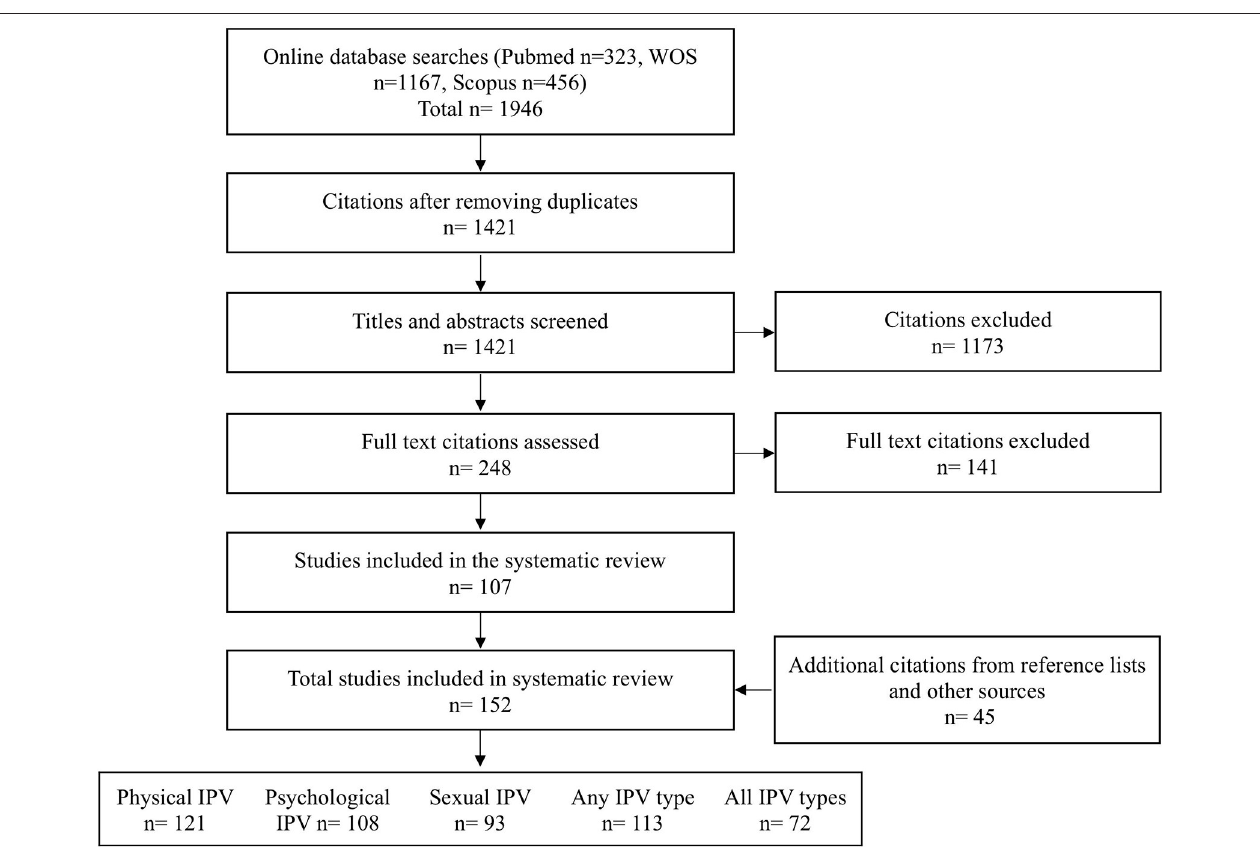
FIGURE 1 | Flowchart systematic review of intimate partner violence during pregnancy.